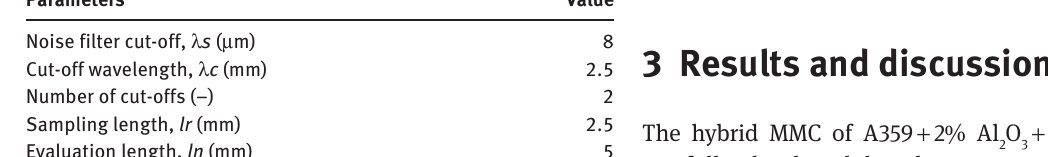
Table 4: Roughness measurement parameters.